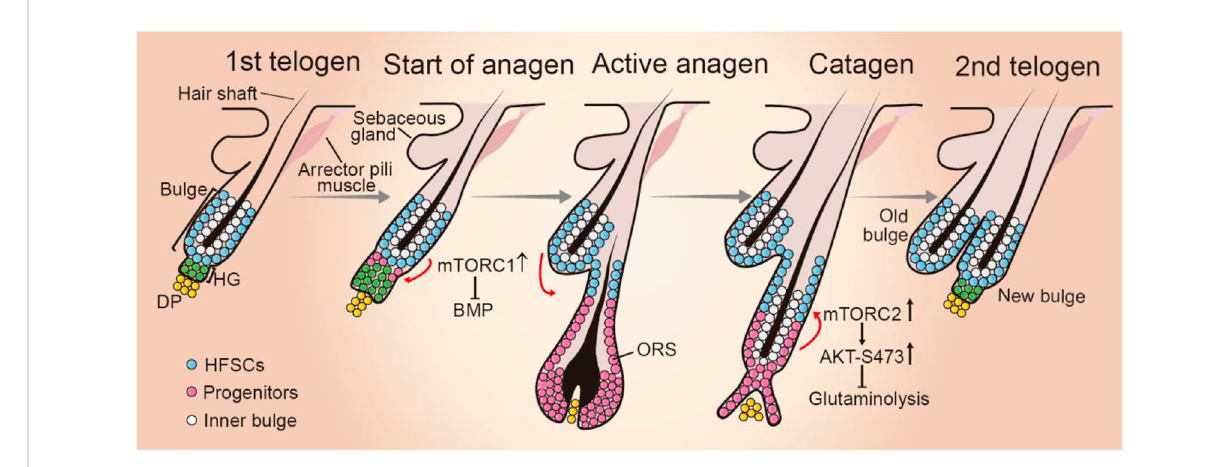
FIGURE 3 Role of mTOR signaling during hair follicle cycling. HF cycling progresses with resting phase (telogen), growth phase (anagen), and regression phase (catagen). At telogen, HFSCs reside in the out layer of bulge in quiescence. In response to environmental cues, hair germ (HG) cells proliferate and initiate anagen phase. HFSCs start proliferate. The progeny migrates downward and forms the structures of new hair follicle. When HF cycling enters catagen phase, the bulge HFSC niche is re-established and become quiescent. mTORC1 activity is critical for HFSC differentiation by suppressing BMP signaling when HF cycling enters anagen phase, whereas mTORC2 plays a role in establishing HFSC niche of newly formed HF at the anagen-catagen transition period by suppressing glutaminolysis. DP, dermal papilla; ORS, outer root